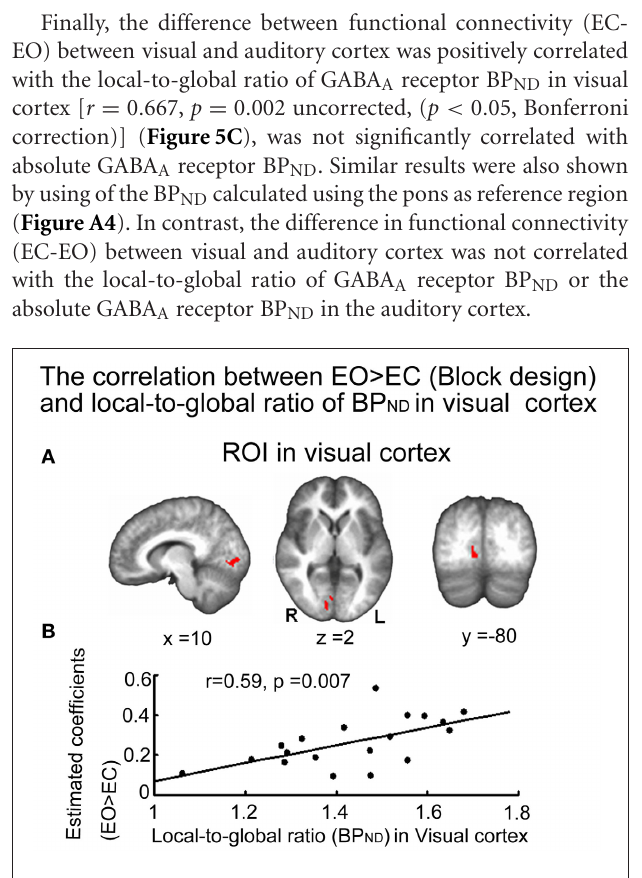
temporoparietal junction; lTPJ, left temporoparietal junction; cACC, caudal cingulate cortex; pACC, perigenual anterior cingulate cortex. ∗ means there is a significant difference ( p < 0 . 05